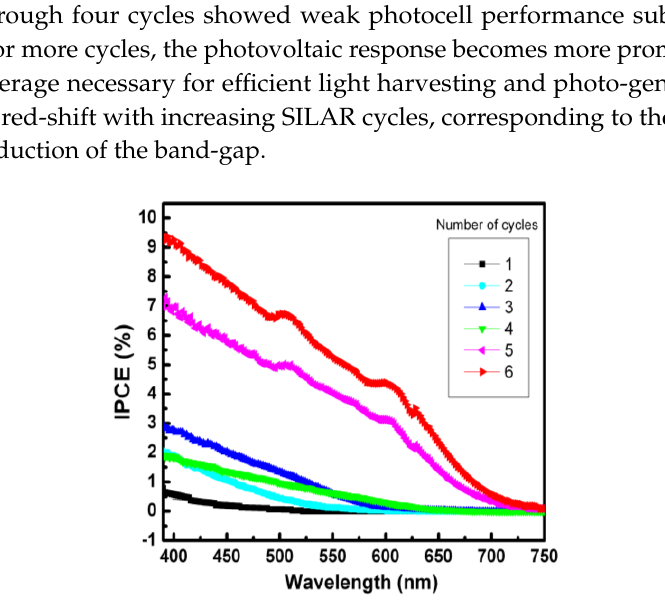
Figure 2. Incident-photon-to-electron-conversion efficiency (IPCE) signals as a function of increasing successive ion layer adsorption and reaction (SILAR) cycle number.